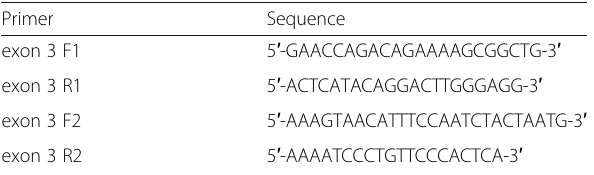
Table 4 Primers sequence for CTNNB1 gene amplification used in this study